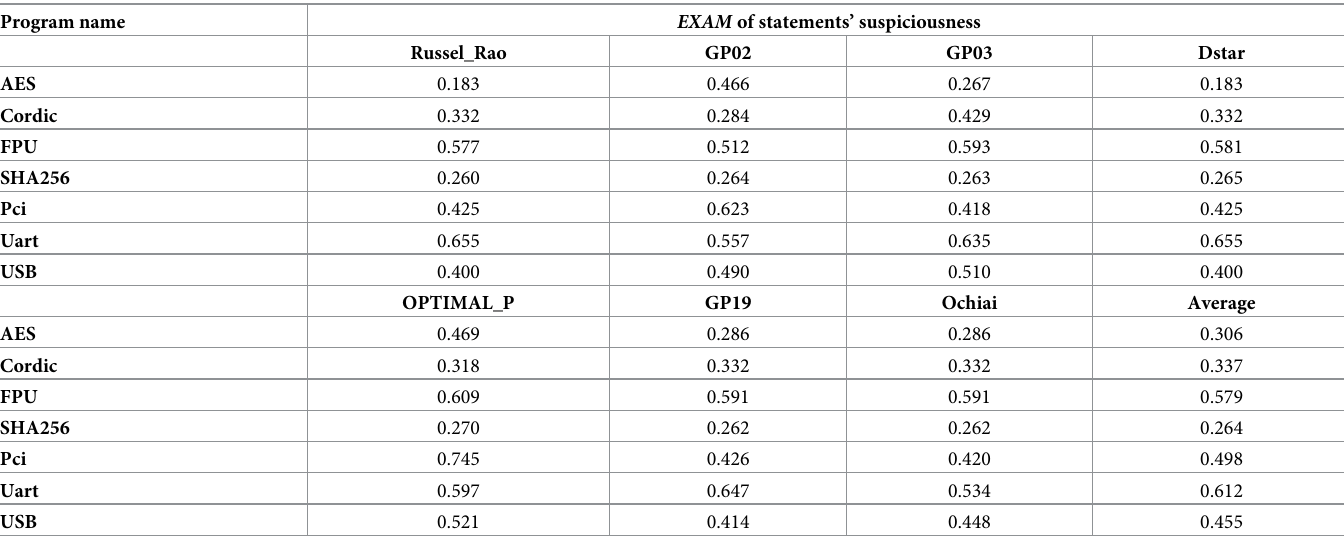
Table 4. EXAM of seven programs on seven evaluation metrics.